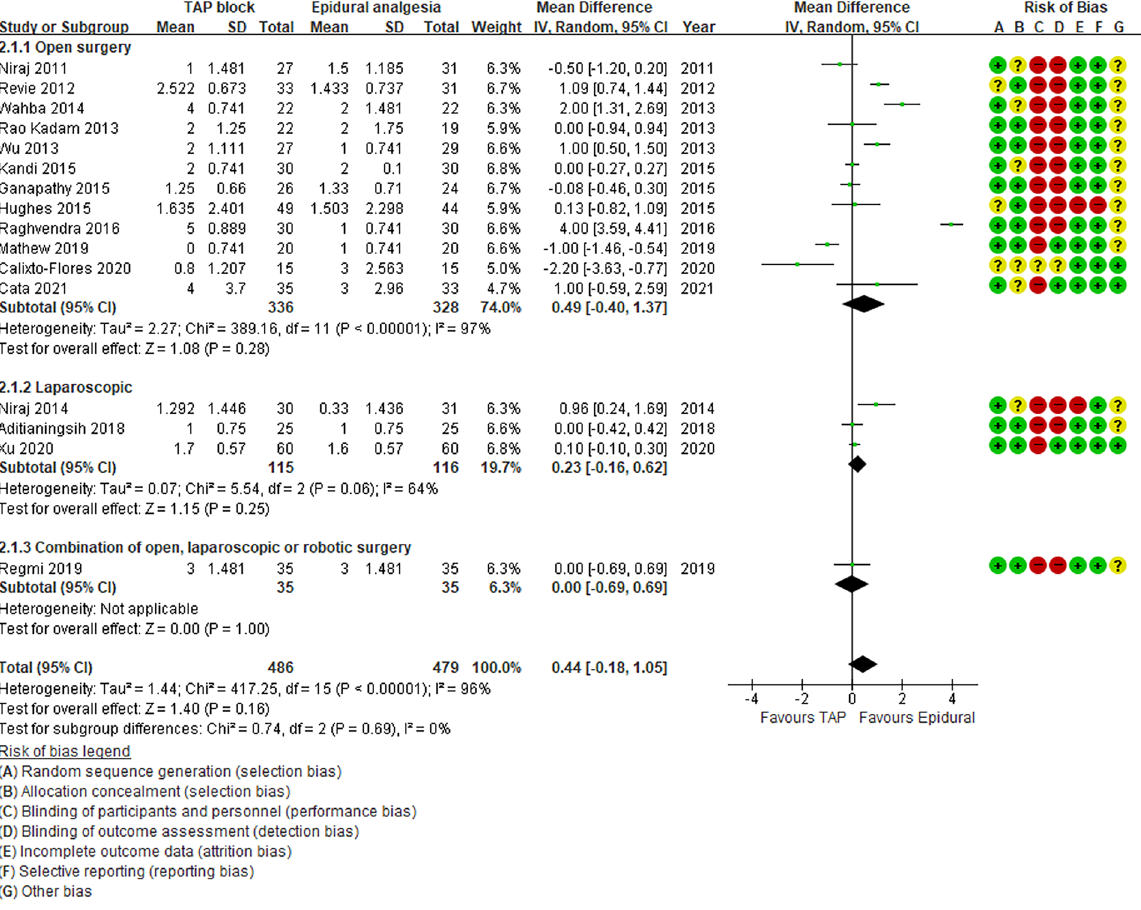
Figure 4. Forest plot of comparison: Pain score at rest at 24 h after